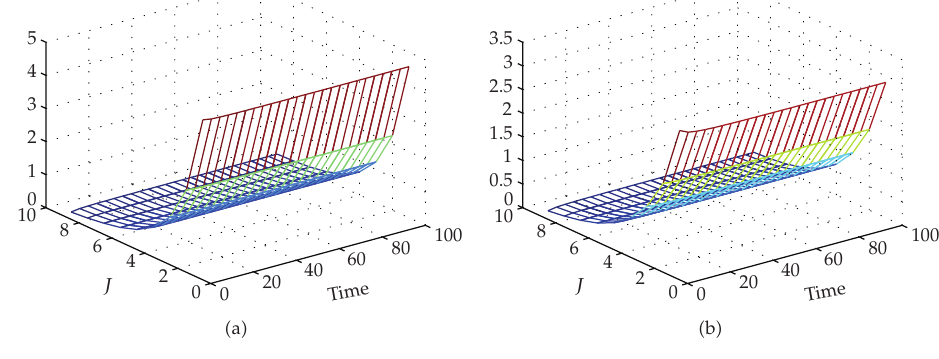
Figure 4: Mean of N (cid:3) t (cid:4) per unit